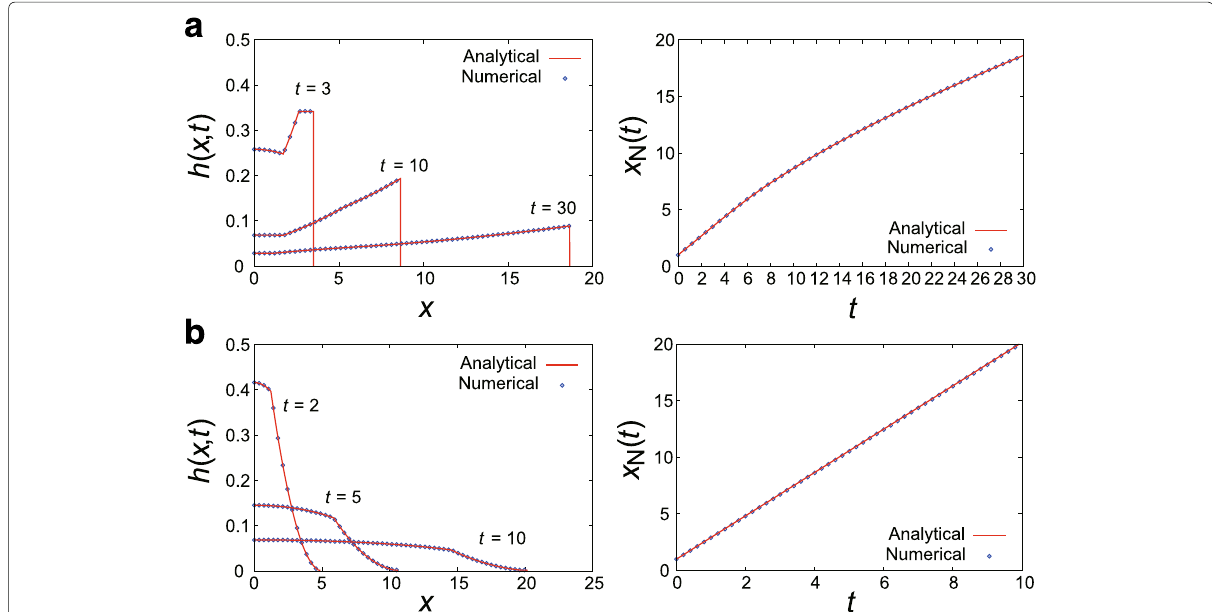
Fig. 6 Analytical results ( redcurves ) and numerical results from the BC model ( bluesymbols ) for h ( x , t ) and x N ( t ) . a ρ c /ρ a = 1.01. b ρ c /ρ a =